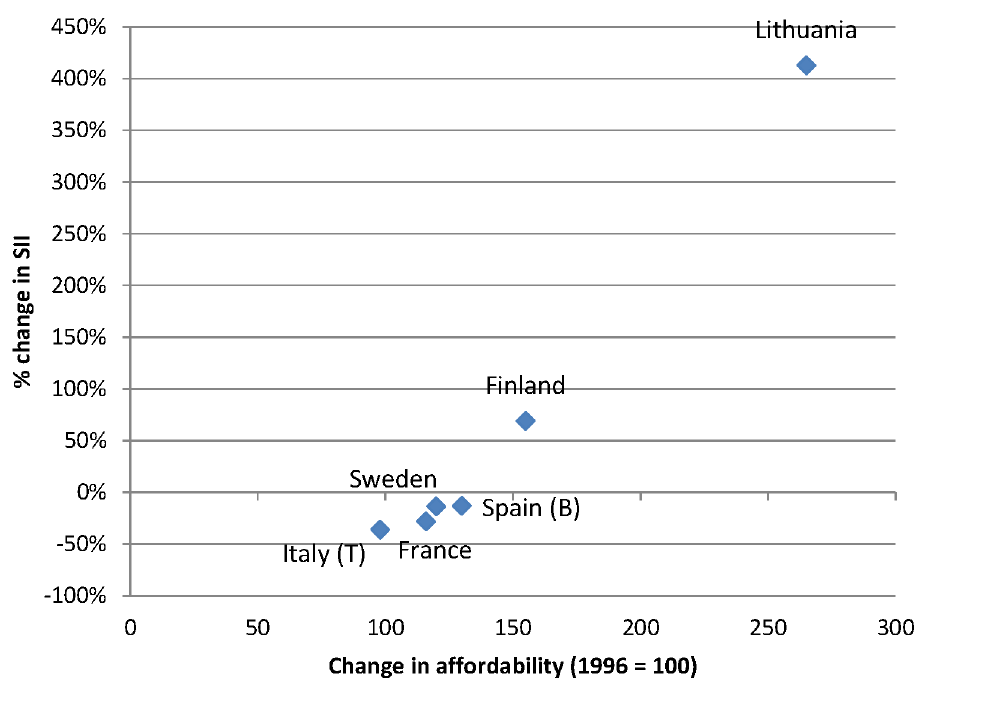
Fig 11. Change in alcohol affordability between 1996 and 2004 versus change in absolute inequality in alcohol-related mortality among men between ca. 1990 – 1994 and ca. 2005 – 2009. Data on affordability are from Rabinovich et al. [59] and give levels of affordability relative to that observed